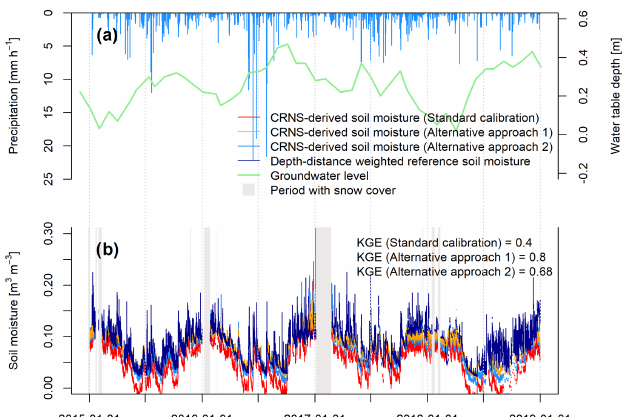
Figure A1. On-site observed hourly rainfall sums (a) and CRNS- derived soil moisture time series based on the standard calibration approach and calibration approaches 1 and 2 in comparison to the depth–distance weighted reference soil moisture time series derived from TDR sensors (b)